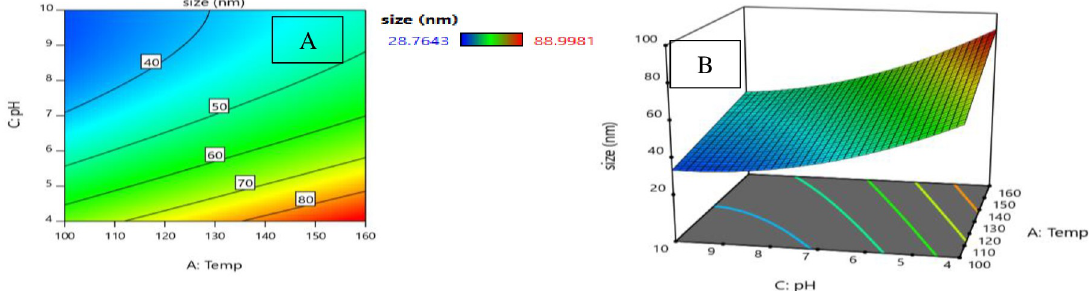
Fig 13. A: 2D contour plots and B: 3D surface plots for the effects of pH and temperature on the percent of crystal size at time 10 h.